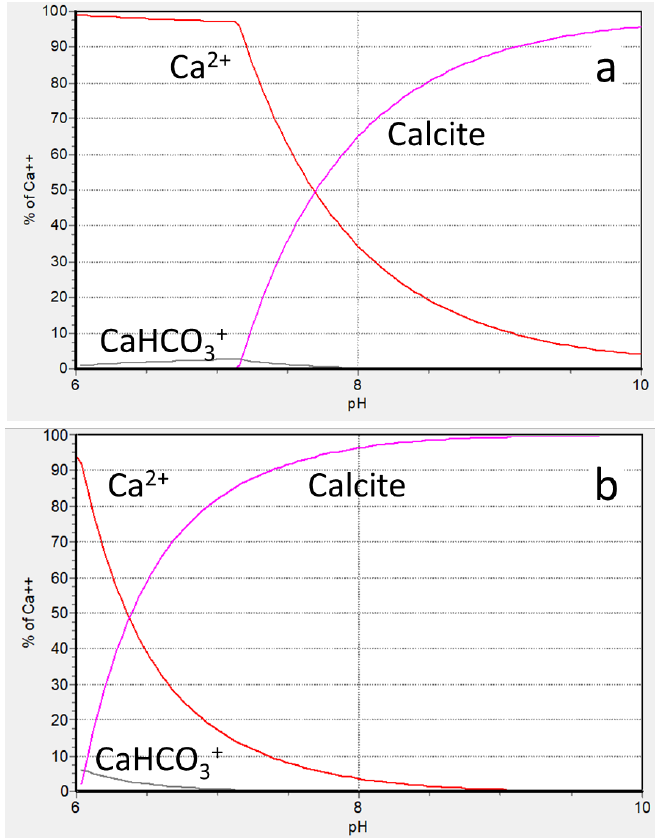
Figure 2. Chemical speciations for 0.25 ( a ) and 1.2 ( b ) mmol·dm ‒3 CaCO 3 as a function of pH at 25 °C and I = 0 mmol·dm ‒3 . Table 2. Calcium species ’ distribution as a function of pH at 25 °C and I = 0 mol·dm ‒3 . Calcium Species, % (mol) рН Са 2+ СаСО 3 solution [СаНСО 3 ] + СаСО 3 calcite